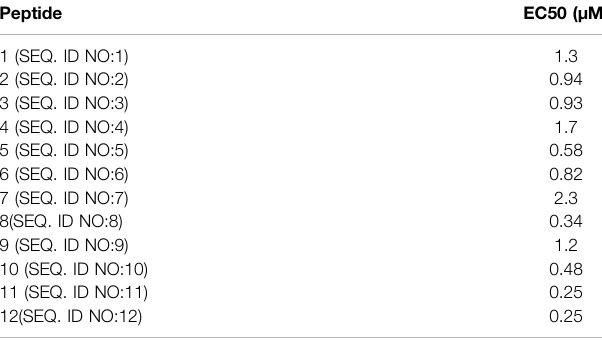
TABLE 2 | EC50 values of peptides determined by cell-cell fusion assay. Peptide EC50 (µM)